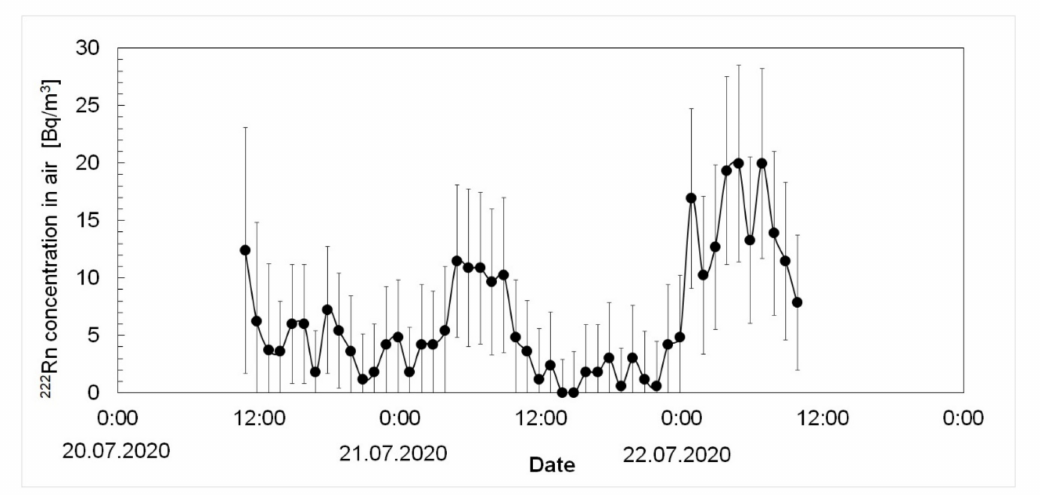
Figure 4. Time variation of radon concentration in air in excavation No. 3. The radon concentration in the air in underground locations may vary by several orders of magnitude. The radon concentration is also influenced by humidity, temperature difference, and pressure between the surface and the underground site. The measured